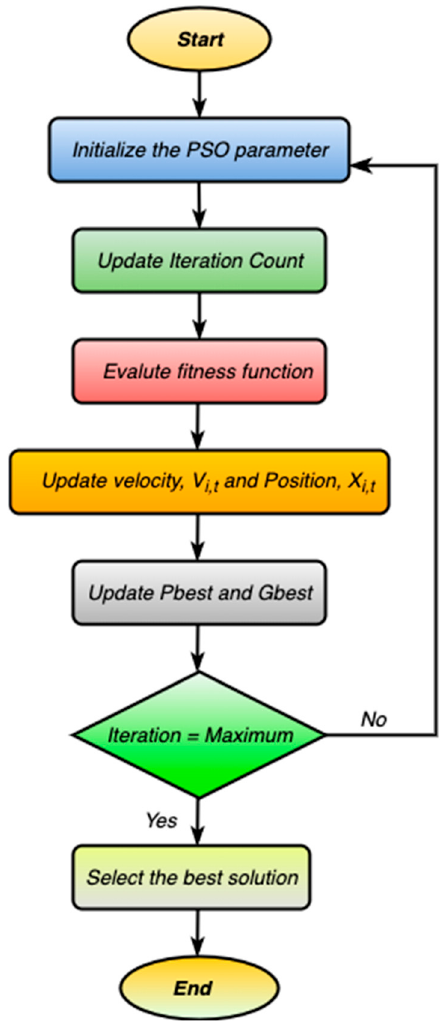
Figure 4. The execution steps of PSO.